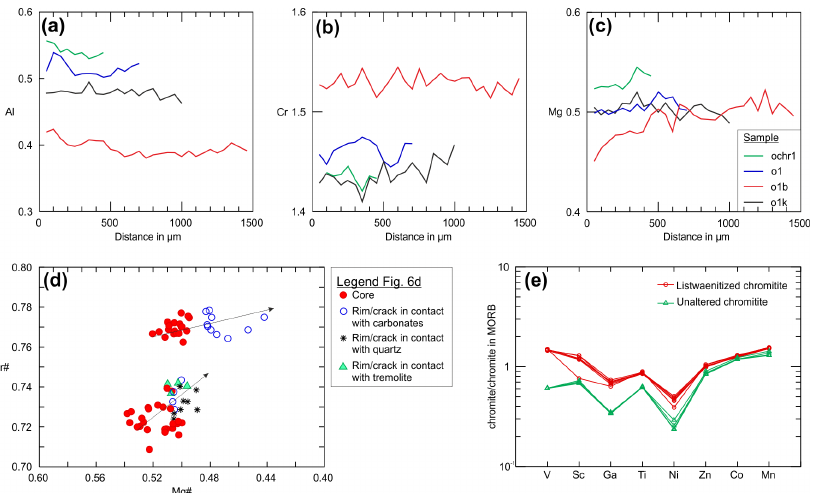
Figure 6. ( a – c ) compositional variations of cation proportions Al, Cr and Mg, respectively through magnesiochromite grains hosted within listwaenitized chromitites (samples: ochr1; o1; o1b; o1k); ( d ) Cr# vs. Mg# diagram of the aforementioned grains distinguished into core analyses and analyses adjacent to rims and cracks, arrows represent the alteration of the magnesiochromite grains; ( e ) nor- malized [32] LA-ICP-MS trace element patterns of magnesiochromite grains hosted within listwae- nitized and unaltered chromitites. Amphibole filling chromitite interstices and magnesite veins is classified as tremolite according to [33] [100 × Mg/(Mg + Fe 2+ ) > 97.67; Si = 7.81–7.93 apfu] (Table S4). Their nor- malized-to-Chondrite (Ch) patterns appear flat and slightly more enriched than chondrite (Table S5), displaying negative anomalies in Hf and Eu (Figure 7a). When normalized to Primitive Mantle (PM) values, the multi-elemental patterns are characterized by (a) posi- tive anomalies in Cs, Th-U, Pb, Nd, and Sm, (b) negative anomalies in Rb-Ba, Nb-Ta, Sr- P, Zr, Eu-Ti, and (c) flat, almost mantle level, HREE (Figure 7b). Chlorite (var. penninite after [34]; Si = 6.7–7.0 apfu; Fe 2+ + Fe 3+ < 0.14,) is chromian with Cr 2 O 3 ranging between 3.3– 5.5 wt%, the thermometer of Kranidiotis et al. [35] yielded temperatures ranging between 127–157 °C (Table S6). Selective analyses of carbonate minerals are presented in Table S7. Figure 7. Tremolite ( a ) Chondrite and ( b ) multielemental Primitive Mantle normalized spider dia- grams, after [36], compared to the metasedimentary rocks of Prinochori Formation as pink field after [26] and subducted sediments from Vanuatu and Gloss II, after [37]. 4.3. Geochemistry Whole-rock analyses were conducted upon magnesite, listwaenites, and their proto- liths (partially in Table 1 and all analyzed elements and mineral assemblages in Table S8), and listwaenitized chromitites were analyzed for their PGE contents (Table S9). According